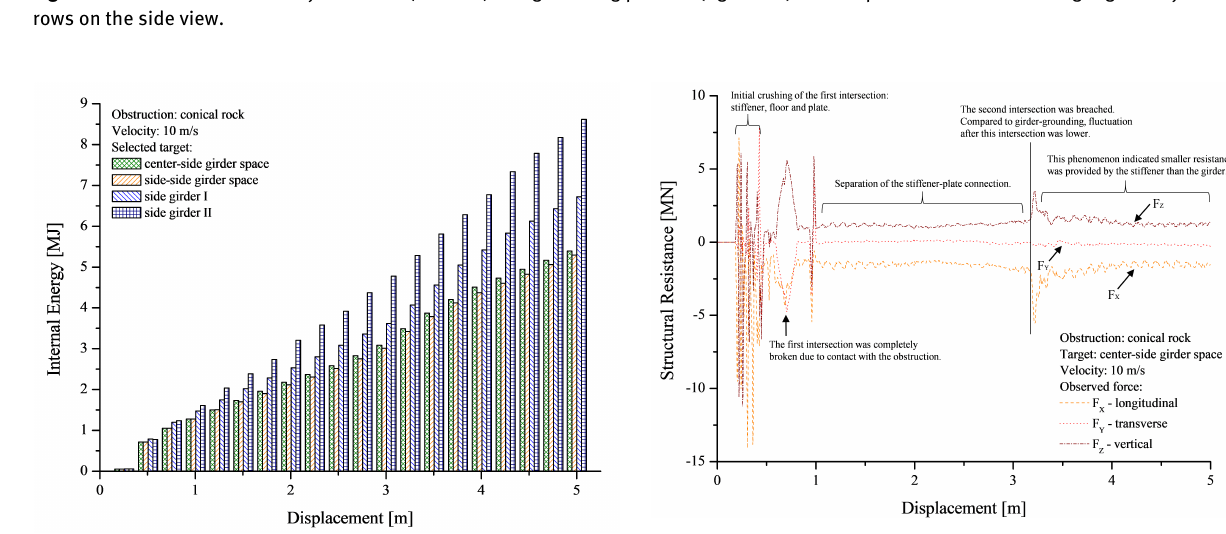
Figure 6: Structural resistance and progressive failure during ship grounding to center-side girder